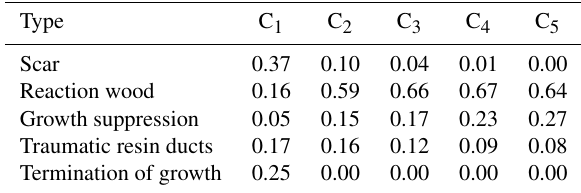
Table A3. Proportion of input types (tree-ring signals) to each growth disturbance (GD) class. Note that there could be multiple input types for each class. Termination of growth indicates that the tree was killed in that year and that it coincides with the historical avalanche record. Some of the termination of growth samples have earlywood if the avalanche occurred in the late winter or early spring. Refer to Table 3 for definitions of